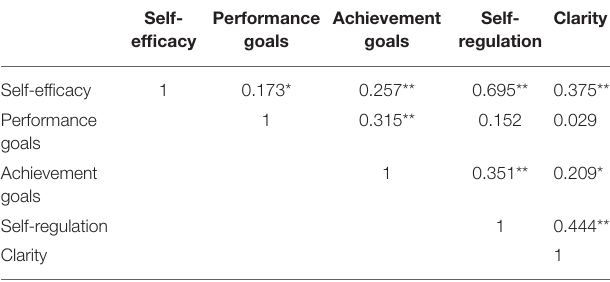
TABLE 7 | Correlations between variables at the end of the study ( n = 145).